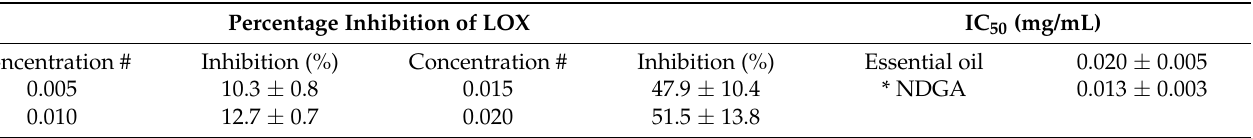
Table 3. IC 50 values and in vitro anti-inflammatory activity of Isolona dewevrei leaf essential oil. Percentage Inhibition of LOX IC 50 (mg/mL) Concentration # Inhibition (%) Concentration # Inhibition (%) Essential oil 0.020 ±